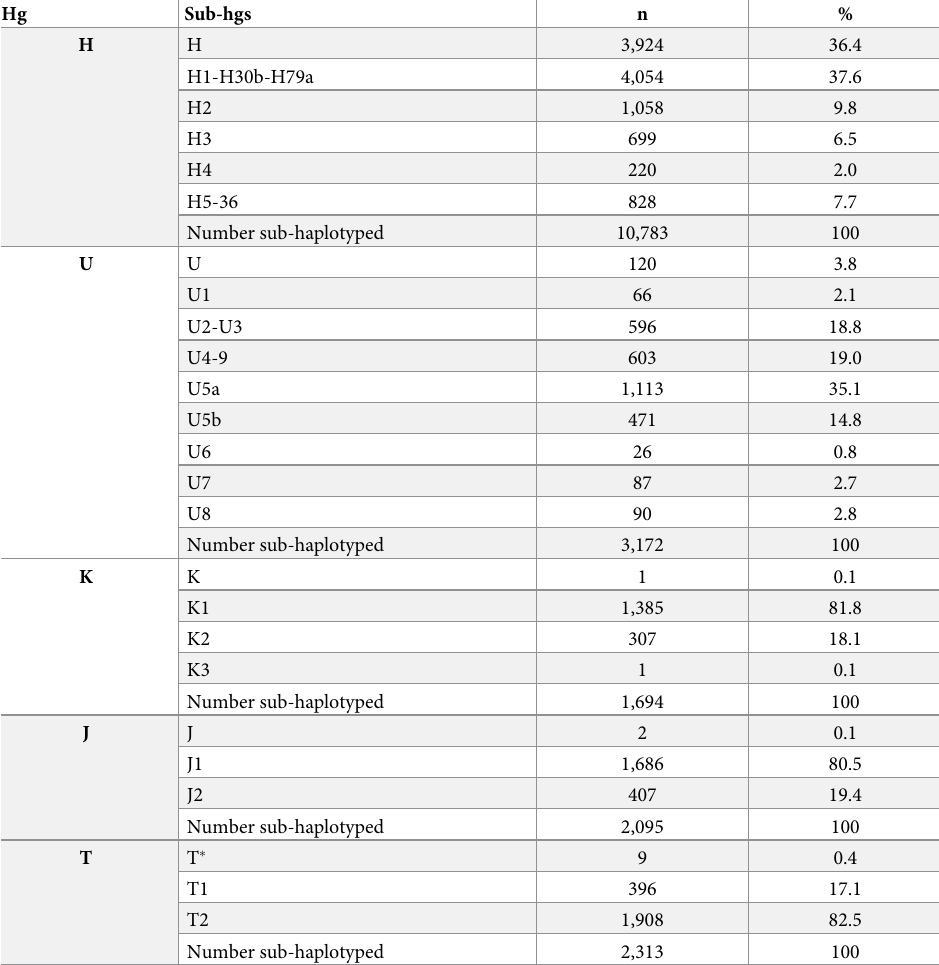
Table 3. Distribution of mtDNA sub-haplogroups of H, V, J, T, K, and U, the most frequent European hap- logroups. HV could not be defined and is included in the H